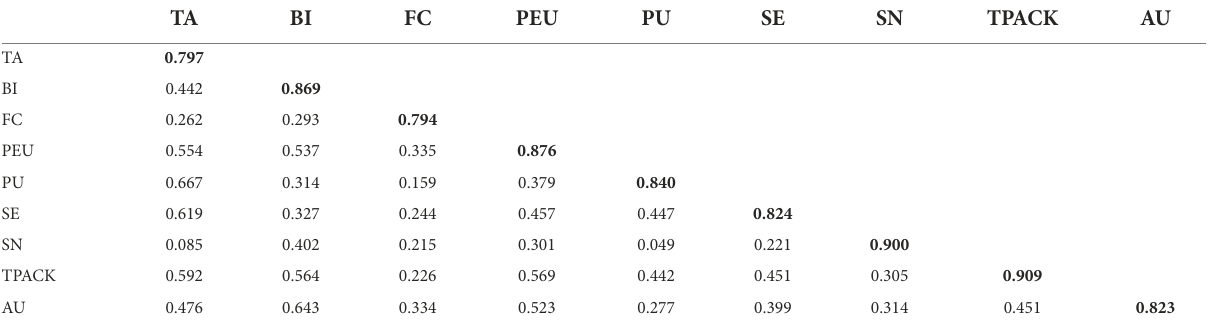
All bolded loadings in the diagonal dimension are larger than those in the vertical.